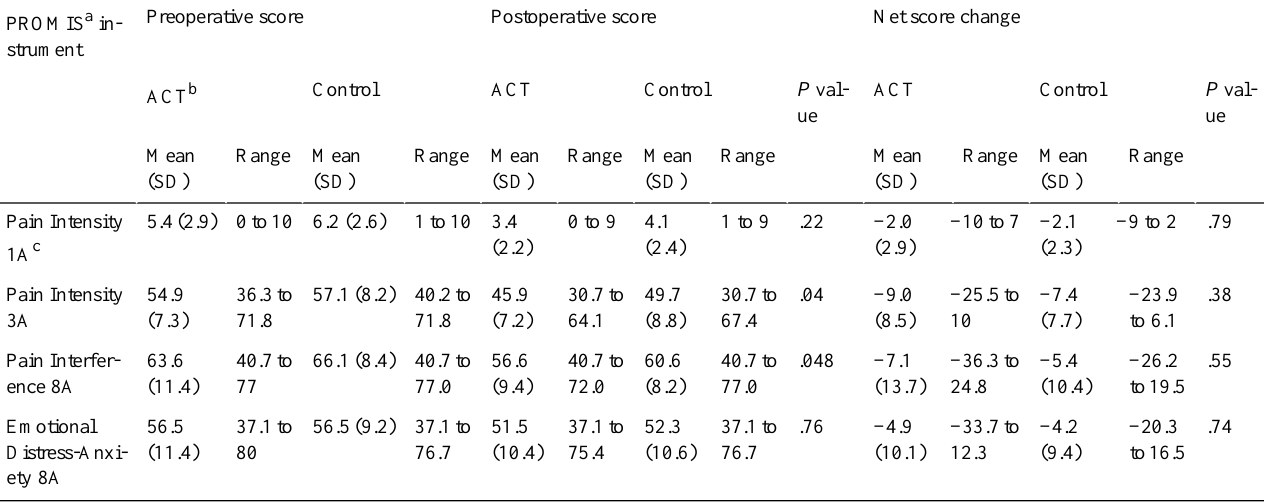
Table 6. Mean Patient-Reported Outcome Measures Information System score and change within the 2-week study period by study